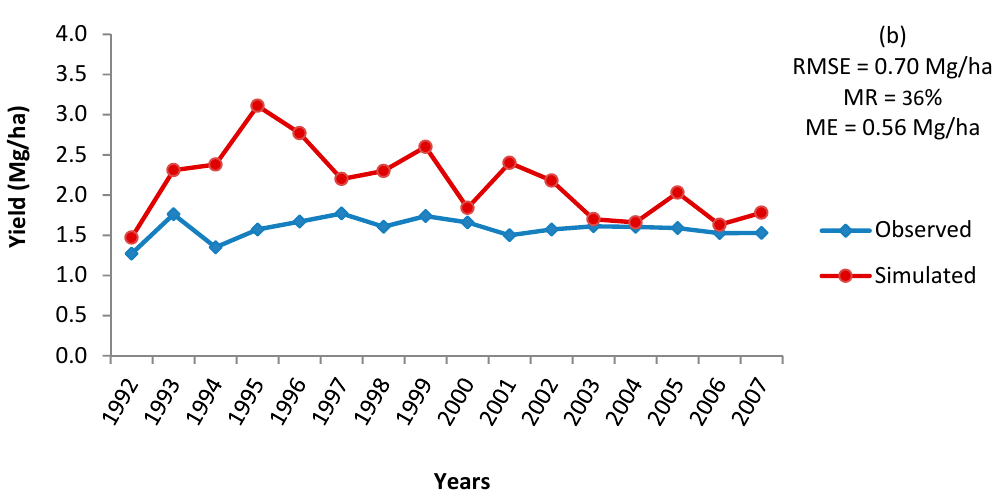
Figure 4. Comparison of observed and simulated maize yield in central Ghana for 16 years (1992–2007) using weather data under Approach 1 (where data were obtained from a single source) ( a ) and Approach 2 (where data were obtained from different sources) ( b ).